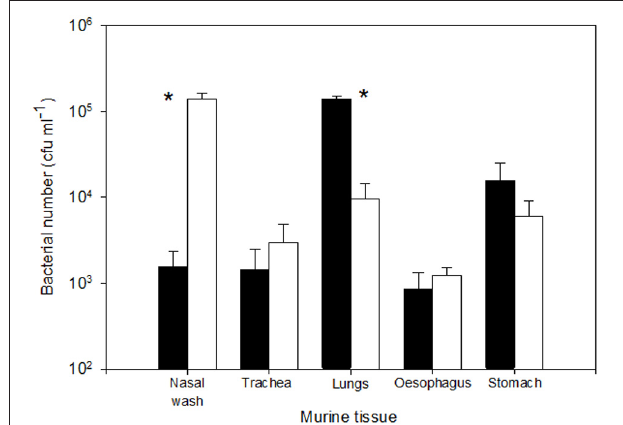
FIGURE 1 | Initial deposition of B. pseudomallei K96243 after exposure to 1 or 12 µ m particle aerosols (shaded and open bars respectively); values represent 30min post-exposure. Error bars represent the standard errors ( n = 10). Asterisks represent significant difference between particle